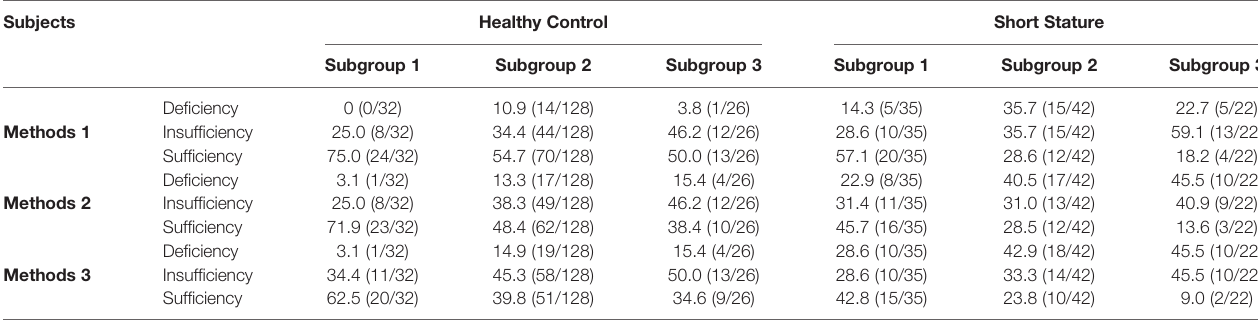
TABLE 2 | Evaluation of the subject ’ s vitamin D nutritional status [%(case/total)].